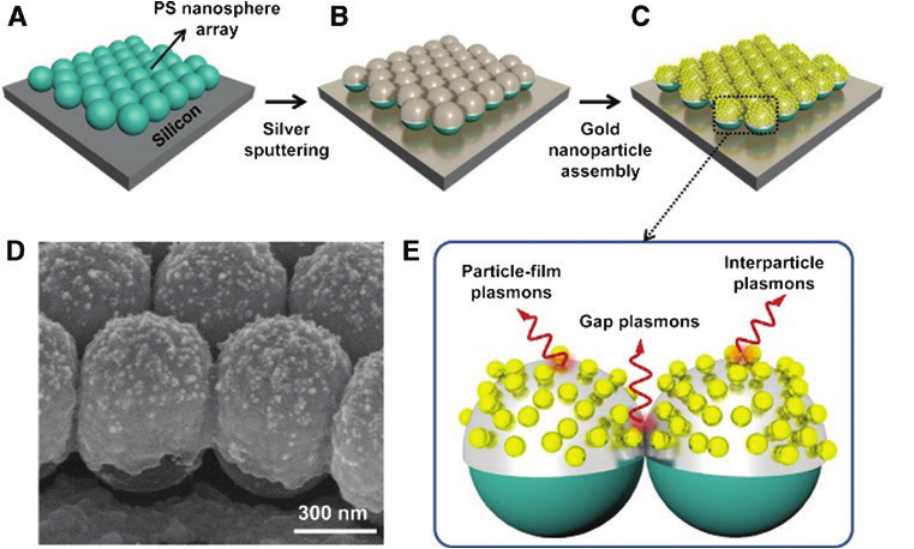
Figure 6: Fabrication procedures of AuNP-AgFON plasmonic systems. Reproduced from Lee et al. ACS Appl. Mater. Interfaces 2016, 8 , 634–642. (A) Self-assembled 2D hexagonal arrays of polystyrene nanospheres on Si substrate, (B) deposition of Ag film by sputtering, and (C) electrostatic assembly of negatively charged Au nanoparticles on positively charged PDDA/AgFON surface. (D) SEM cross-sectional image of AuNP-AgFON-505. (E) Multiple field enhancements are generated from particle–film, interparticle, and crevice gap plasmon couplings. Copyright © 2015 American Chemical